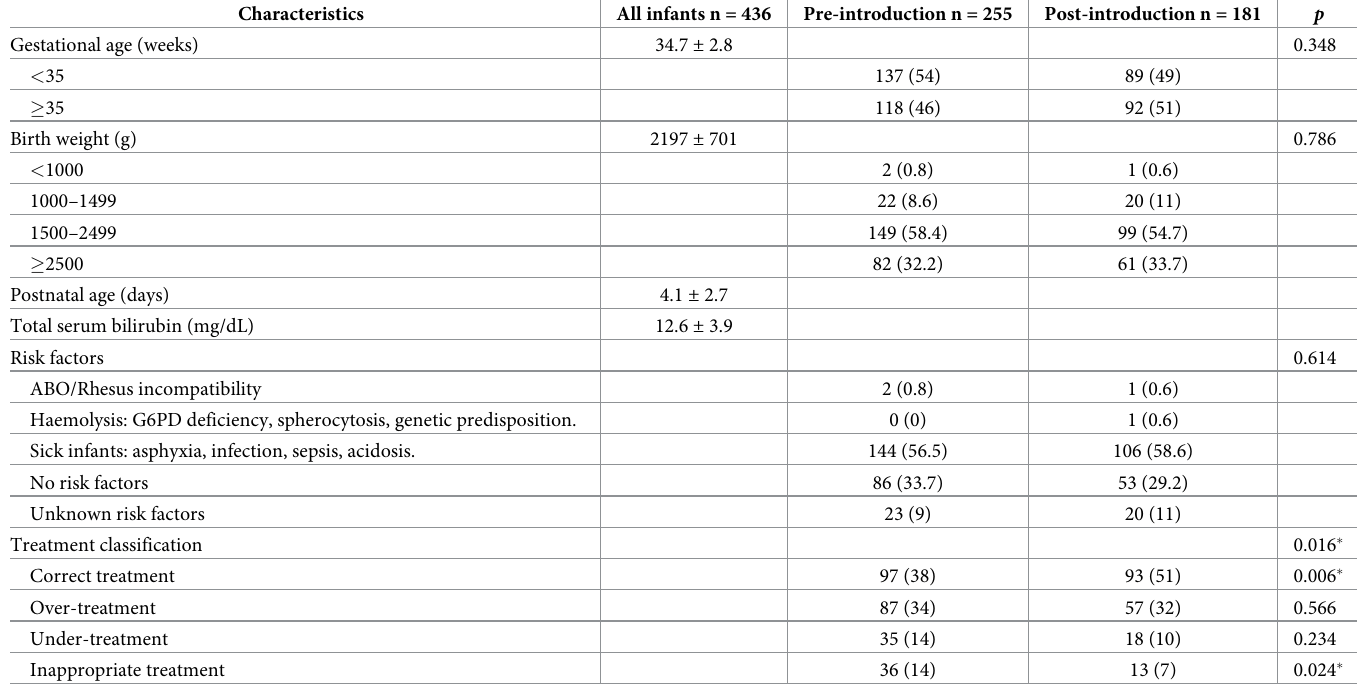
Table 2. Patient characteristics before and after BiliNorm